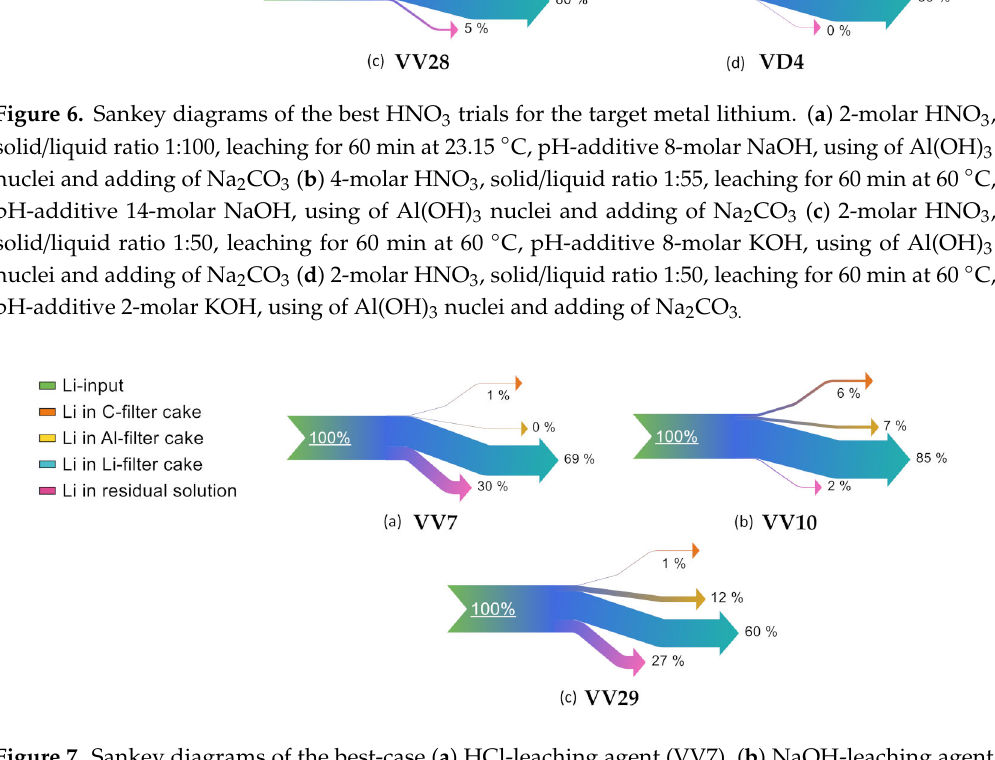
Figure 7. Sankey diagrams of the best-case ( a ) HCl-leaching agent (VV7), ( b ) NaOH-leaching agent (VV10), and ( c ) H 2 SO 4 -leaching agent (VV29).